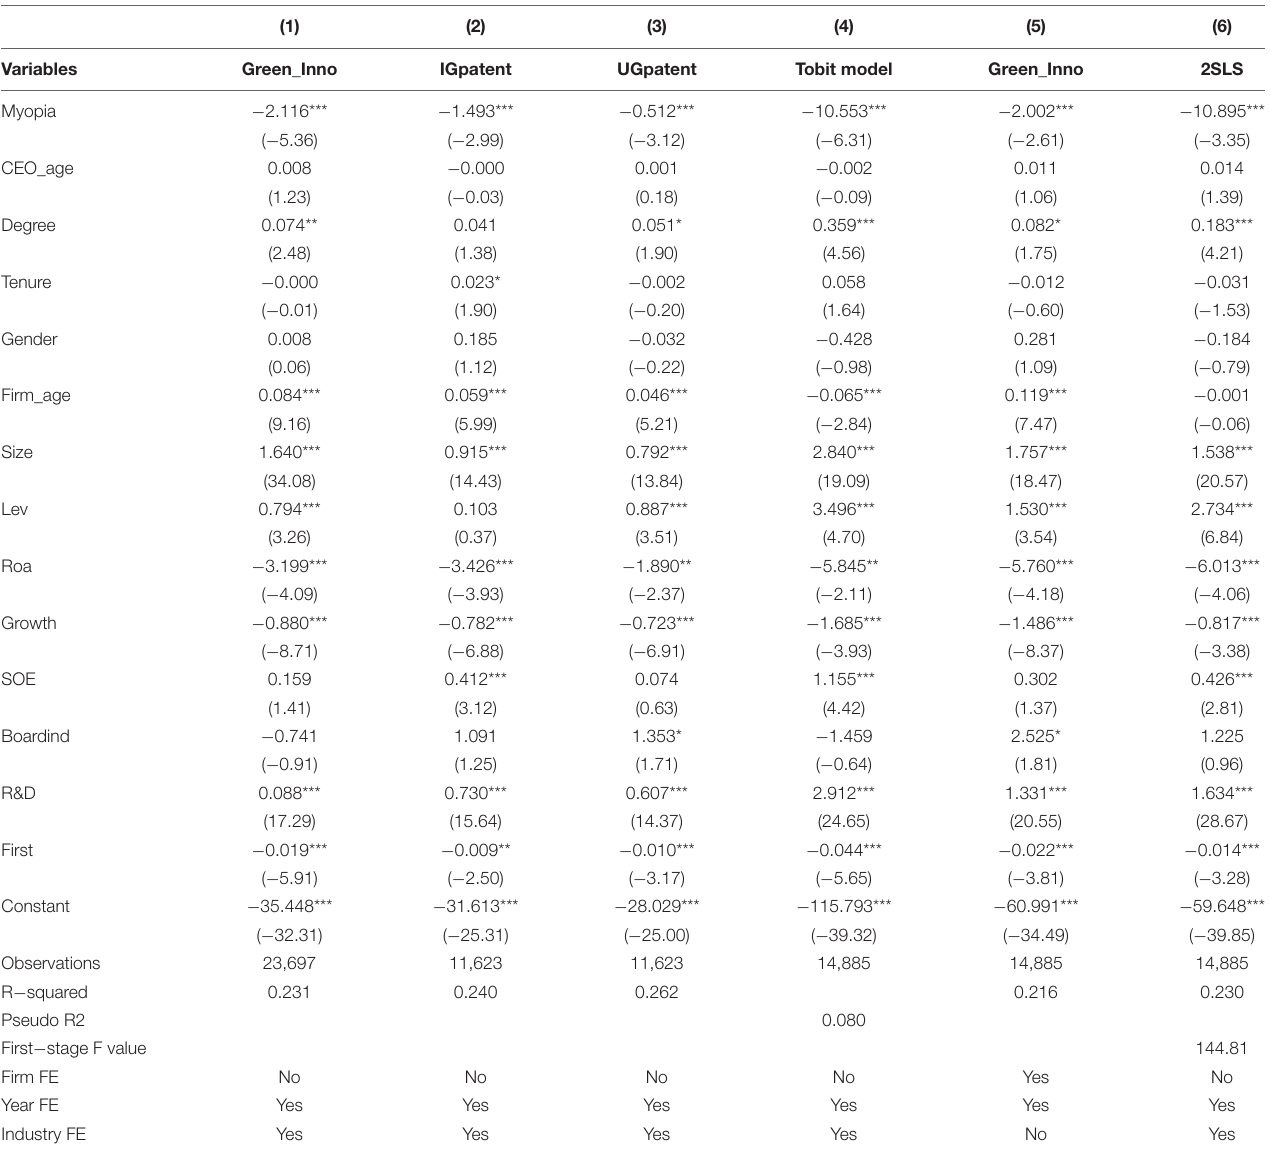
TABLE 6 | Test of